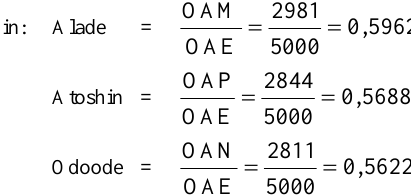
Figure 4: Lorenz curves for male marketers in cocoa industry in Alade, Atoshin, and Odoode in Idanre, Ondo State, Nigeria. 2000/2001 Season Source: Akinola,